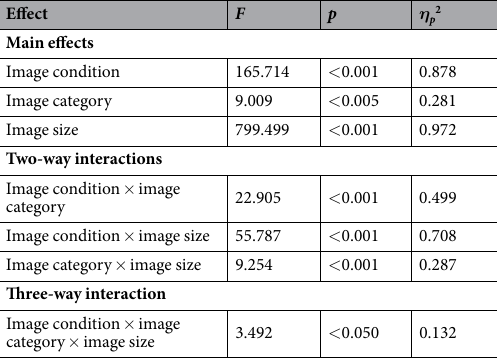
Table 4. Results of the 2 × 3 × 5 (image condition × image category × image size) ANOVA for